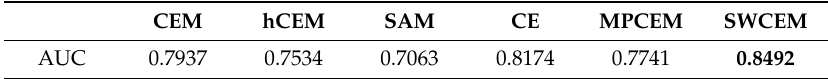
Table 2. The area surrounded by ROC curves of different algorithms on the second scene.